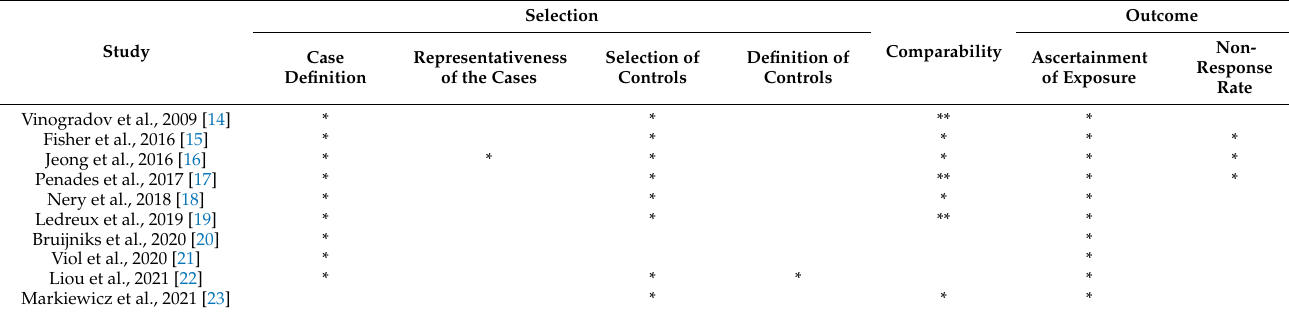
Table 1. Evaluation of risk